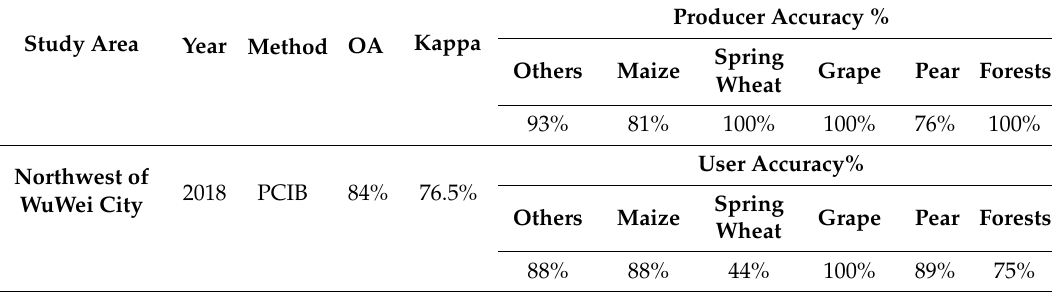
Figure 10. Classification mapping results for the northwest of Wuwei City in 2018. Table 12. Accuracy analysis of PCIB method for the northwest of Wuwei City.